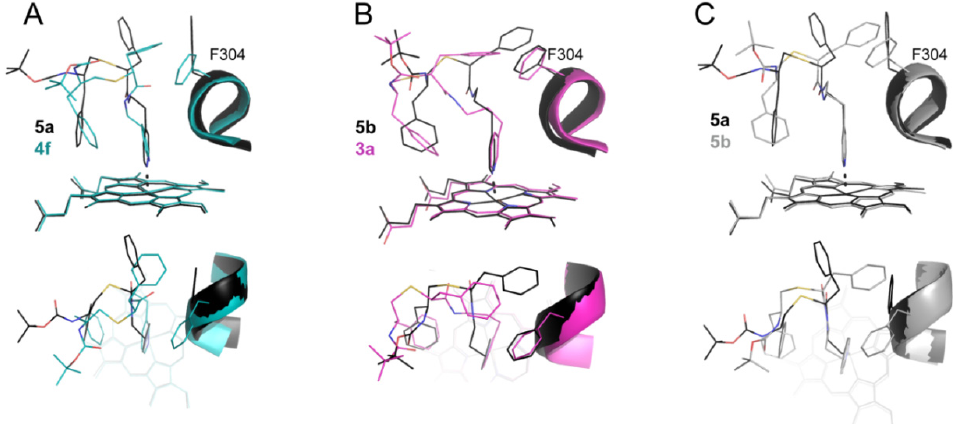
Figure 4. Structural comparison of 5a – 4f ( A ), 5b – 3a ( B ), and 5a – 5b pairs ( C ). The side and top views (upper and lower panels, respectively) illustrate differences in the backbone and side-group positioning. The central part of the I-helix is displayed to show the adaptive rotameric changes in Phe304. The 3a - and 4f -bound structures of CYP3A4 used for comparison have PDB ID codes of 7KVH and 6DAC, respectively. Table 3. Structural features of the inhibitory complexes.